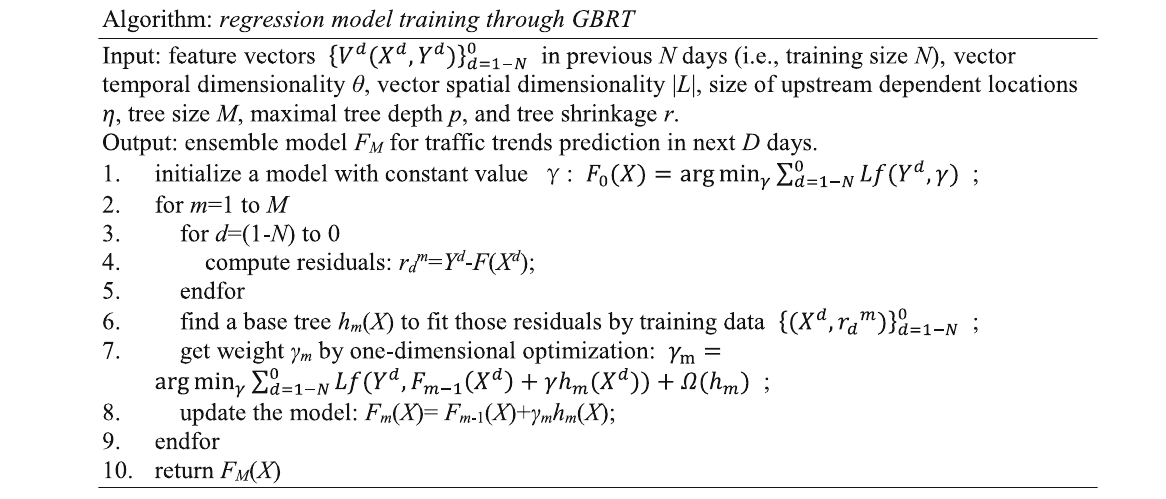
Table 2 Model training to predict daily traffic